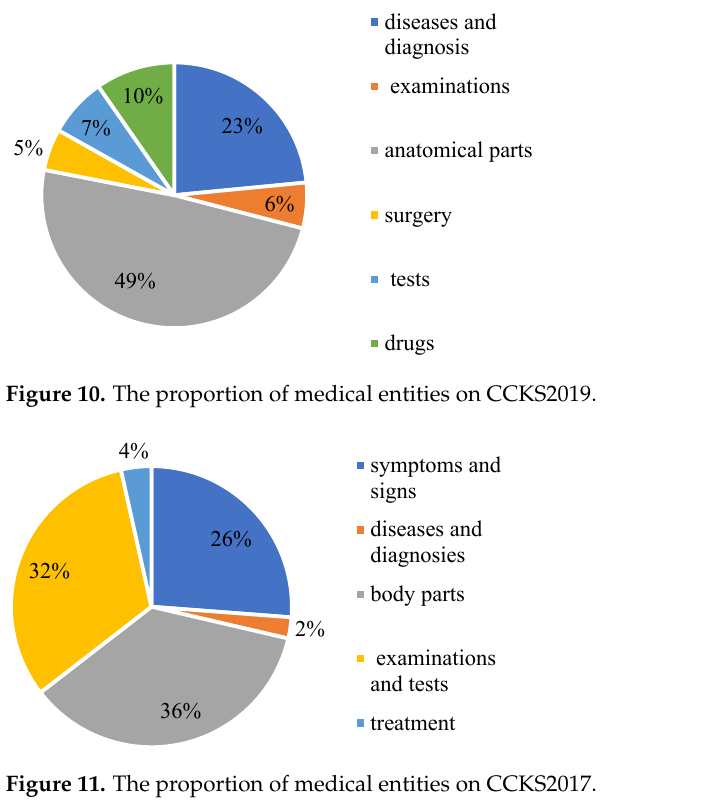
Figure 11. The proportion of medical entities on CCKS2017.